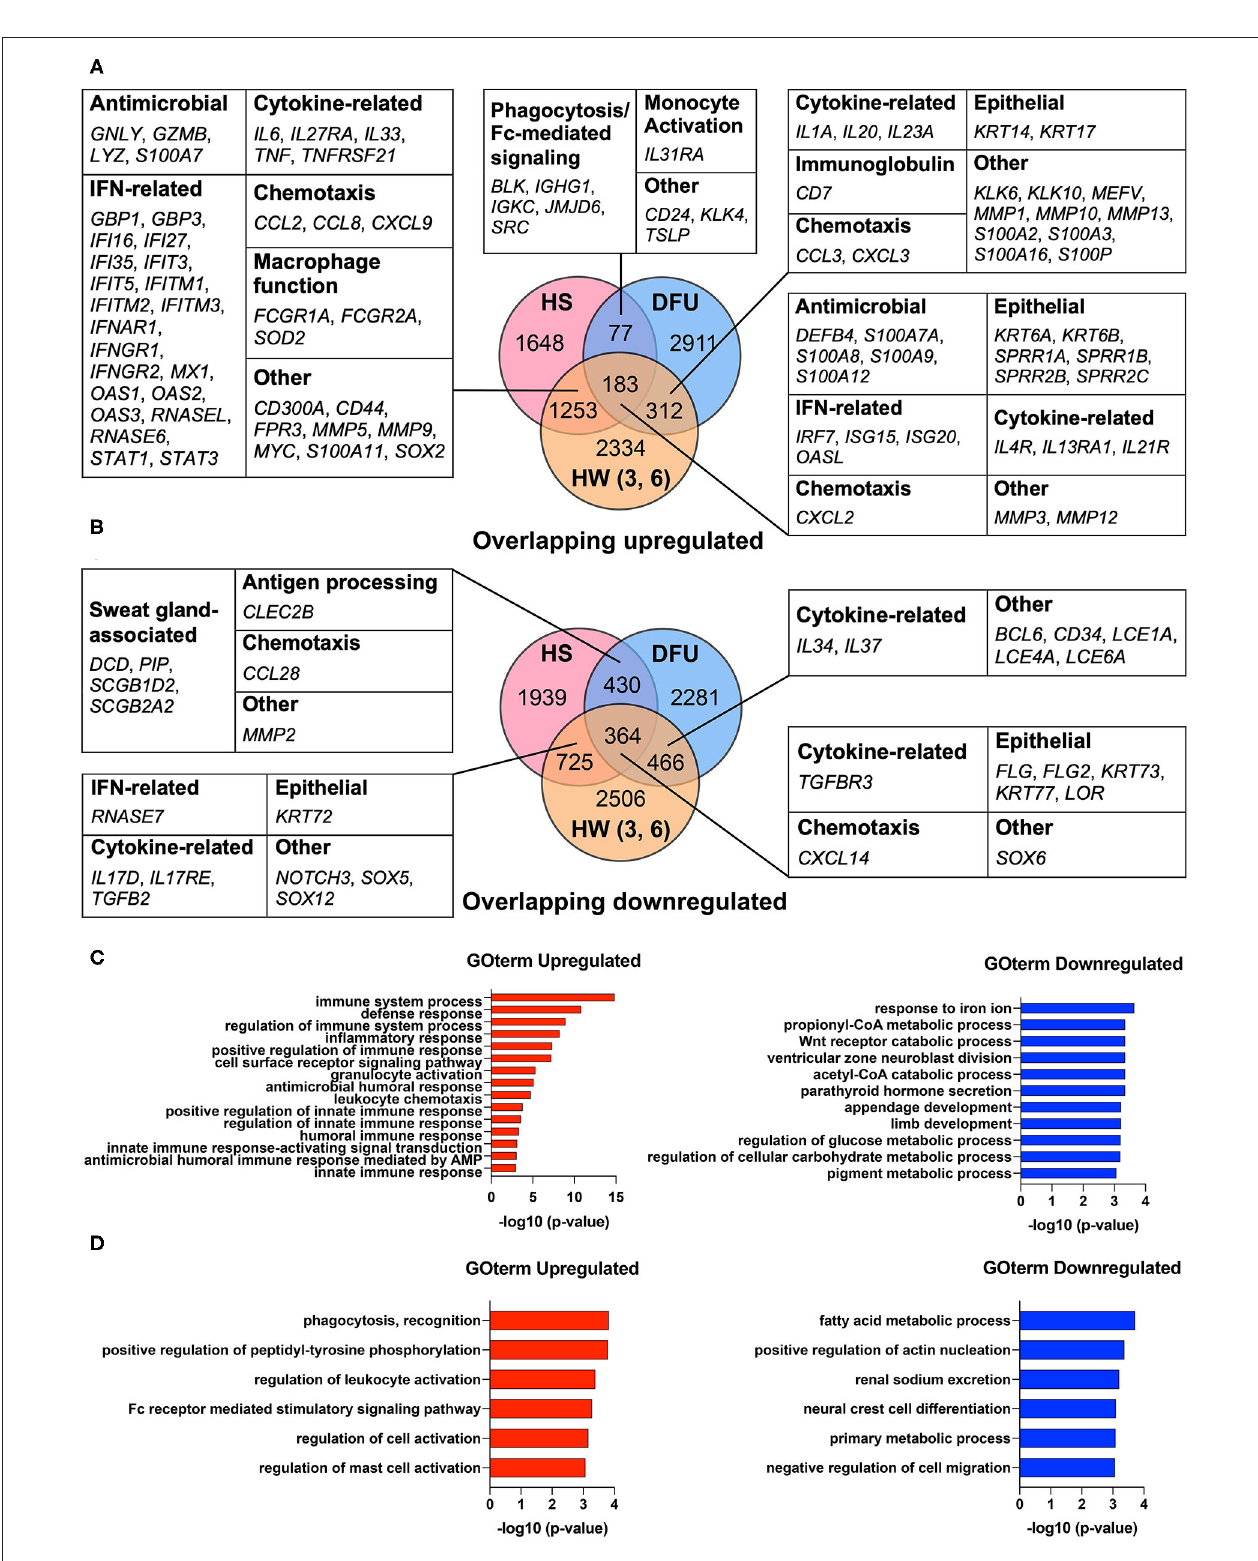
FIGURE 1 | HS and DFU share an increased innate immune response enriched in macrophage function. (A) Notable upregulated DEGs shared between HS, HW, and DFU organized by biological function. Numbers in overlapping circles indicate the amount of shared upregulated genes for that respective comparison.